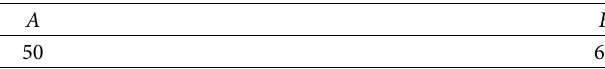
Table 2: Durations of activities.